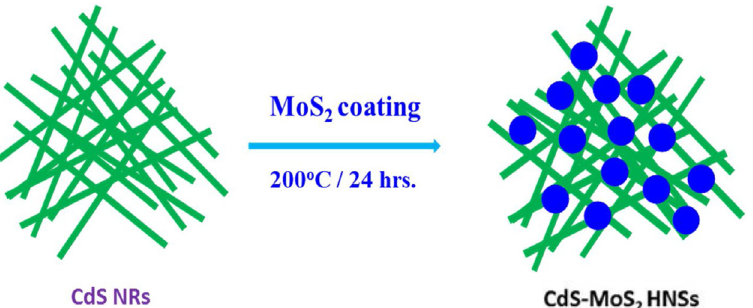
Figure 22. Schematic illustration of synthesis protocol for the fabrication of 1D CdS/2D MoS 2 . Copyrights 2018 Elsevier [182].